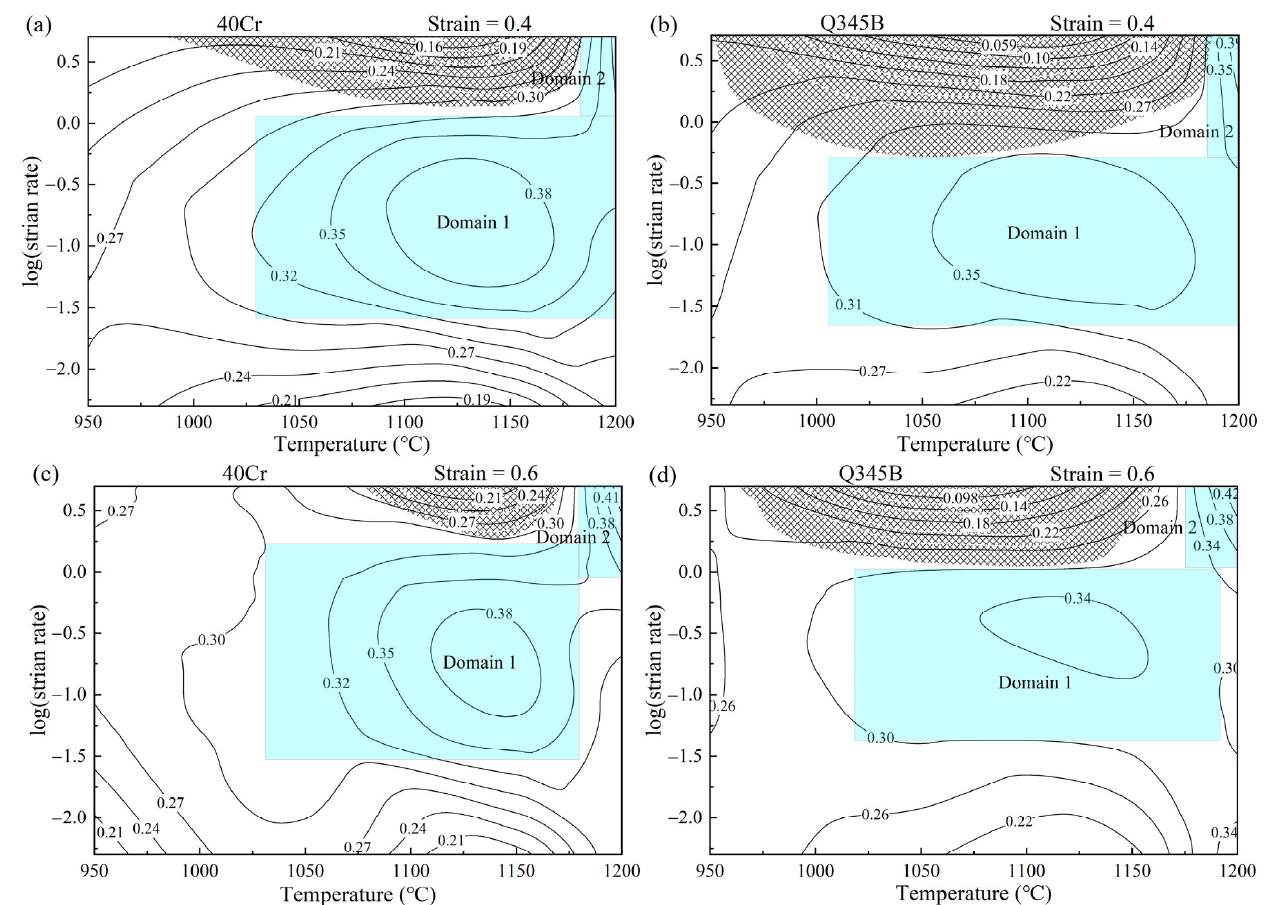
Figure 14. Processing maps at different strains: ( a ) 40Cr, ε = 0.4; ( b ) Q345B, ε = 0.4; ( c ) 40Cr, ε = 0.6; ( d ) Q345B, ε =